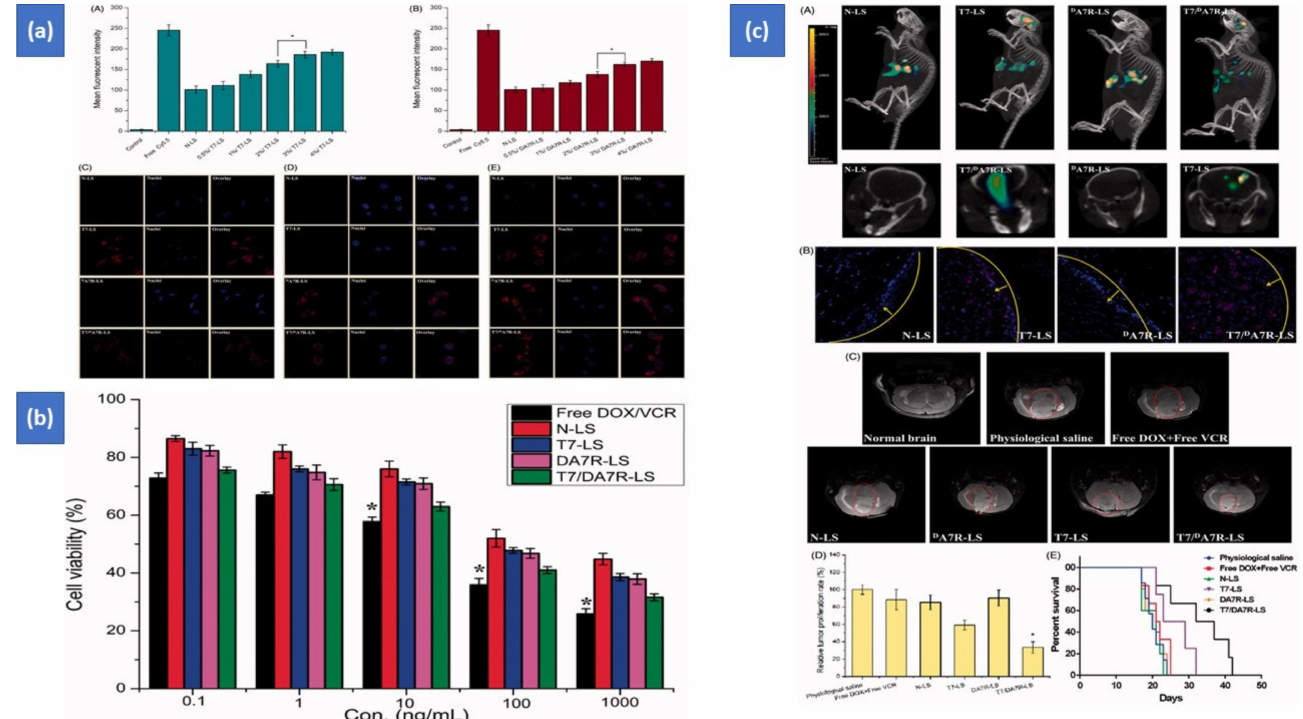
Figure 3. Targeted liposomes having two peptides (TfR- and VEGFR2-specified peptides) and two antitumor agents (doxorubicin and vincristine). ( a ) Cellular uptake (After 2 h at 37 ◦ C, cellular uptake of Cy5.5-loaded liposomes of varying densities of T7 ( A ) and DA7R ( B ) in C6 cells. The cells’ auto-fluorescence was used as the control. Cellular uptake of varied Cy5.5 loaded lyposomes by bEND.3 cells ( C ), HUVECs ( D ), and C6 ( E ) cells); ( b ) cytotoxicity study (The cytotoxic activity of free DOX + free VCR, as well as some liposomes containing DOX and VCR); ( c ) biodistribution study (The biodistribution of Cy5.5 in varied liposomes in mice with intracranial C6 glioma was ascertained using an IVIS®Spectrum-CT ( A ). A CLSM was used to show the allocation of Cy5.5 in the brains of mice with intracranial C6 glioma ( B ). 16 days after inoculation, MRI of physiologic and pathological brains ( C ). Glioma tumor cell division rate in the brain ( D ). Survival curves according to Kaplan–Meier ( E ). The yellow line represents the intracranial glioma margin, and the arrow represents the glioma cells. The red is Cy5.5, and the nuclei are stained with DAPI (blue). Effectiveness after treatment with different formulations at 1 mg/kg (DOX 0.8 mg/kg + VCR 0.2 mg/kg) on days 8, 10, 12, and 14 after inoculation.) This designed system could go through the blood–brain barrier and blood–tumor barrier, with enhanced cellular uptake and cytotoxicity [32]. Copyright 2017, Taylor & Francis Journals. * p <